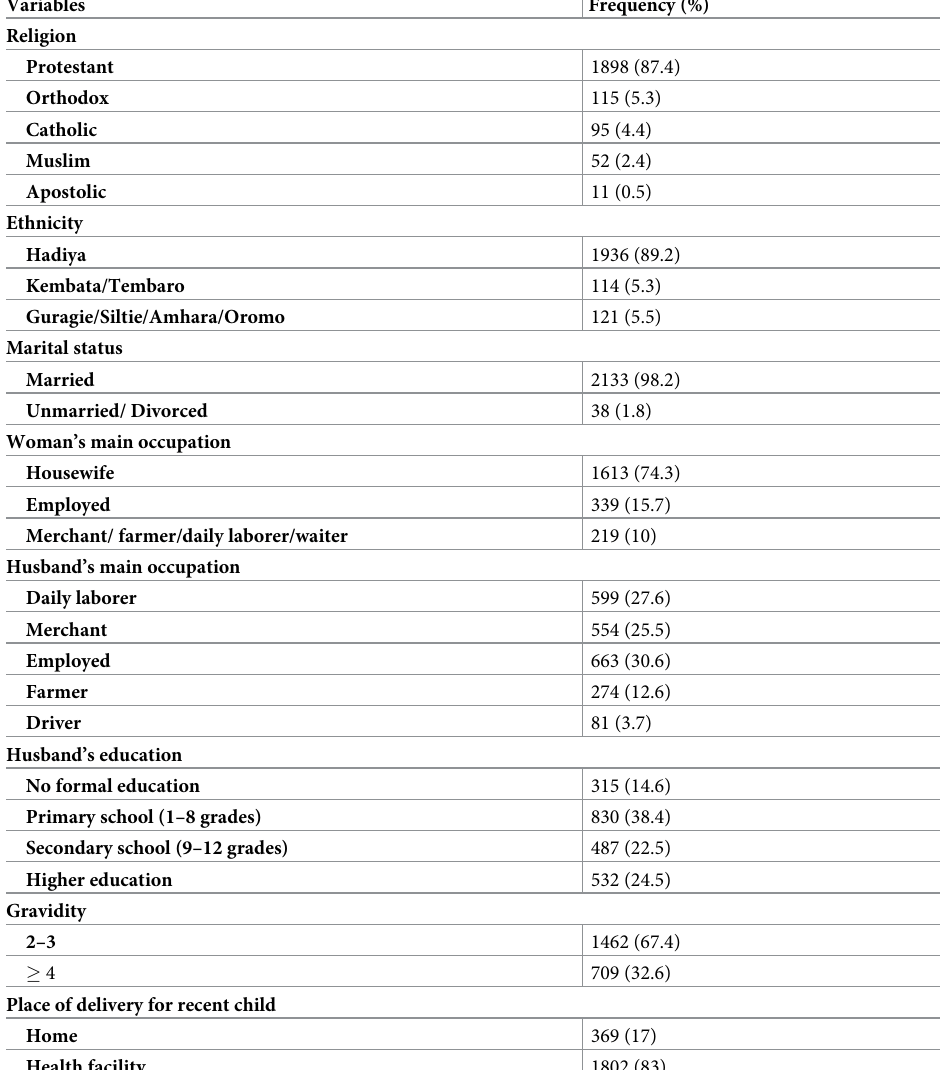
Table 2. Socio-demographic and reproductive characteristics of pregnant women in five urban settings in Hadiya zone, South Ethiopia,